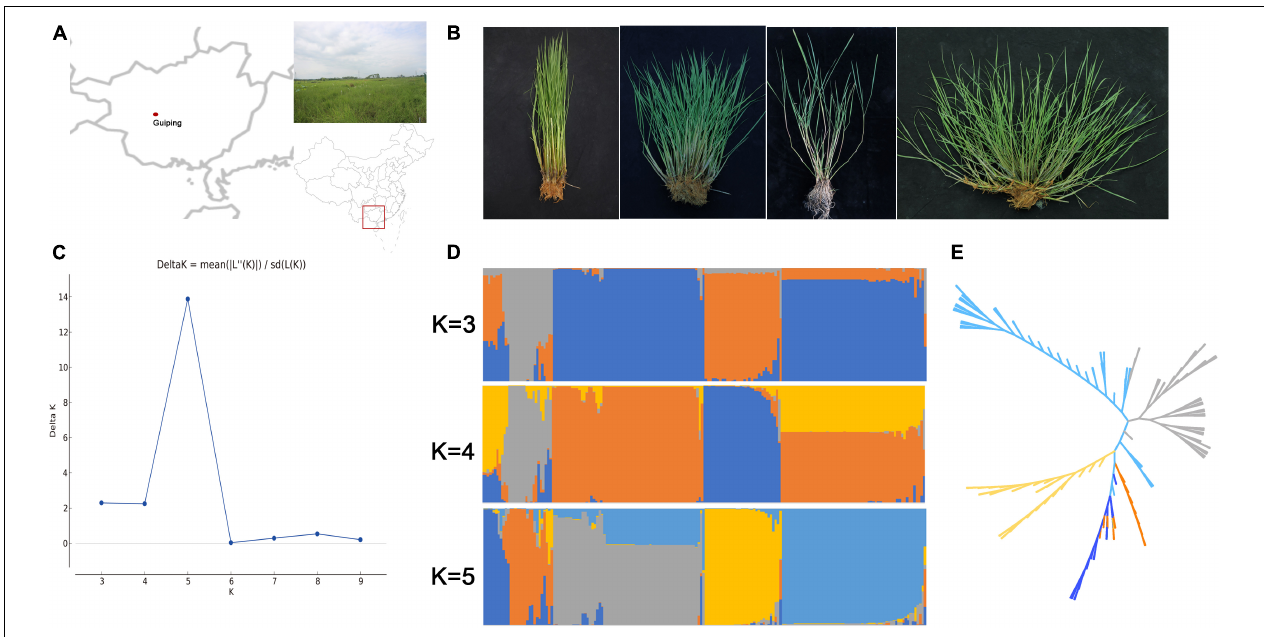
FIGURE 1 | Genetic diversity in the Guiping in situ conserved wild rice population. (A) Location of the Guiping in situ wild rice conservation site. (B) Four plant architecture types among the Oryza rufipogon individuals in the Guiping population (left to right: erect, semi-erect, tilted, and creeping). (C) Delta K values for the STRUCTURE analysis. (D) Clustering of 184 individuals in the Guiping wild rice population according to the STRUCTURE analysis ( K = 3–5). (E) UPGMA dendrograms constructed on the basis of Nei’s standard genetic